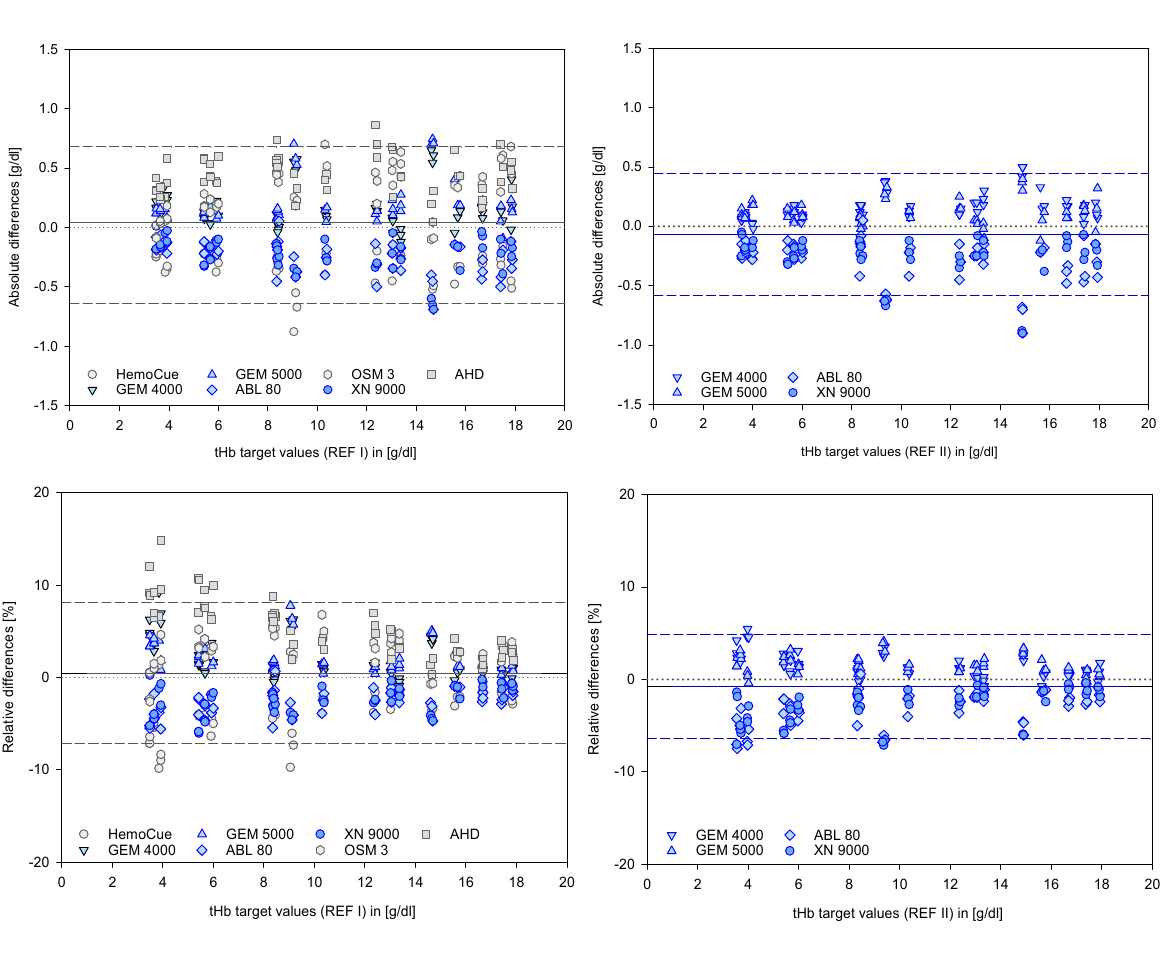
Figure 3. Absolute differences in g/dL ( top ) and relative differences in percent versus the respective target values ( bottom ) in g/dL. Left : for all devices in test with REF I, right : for the clinically relevant devices under test with REF II. Lines represent mean +/ − 1.96 SD with respect to the B and A analysis. Table 4. The absolute differences in [g/dL] according to the Bland and Altman procedure with bias (mean), precision (+/ − SD), and limits of agreement (+/ − 1.96 SD). The relative differences are expressed as percentages compared to the respective target values in [g/dL]. Absolute Differences in [g/dl] Relative Differences in [%] All Device in